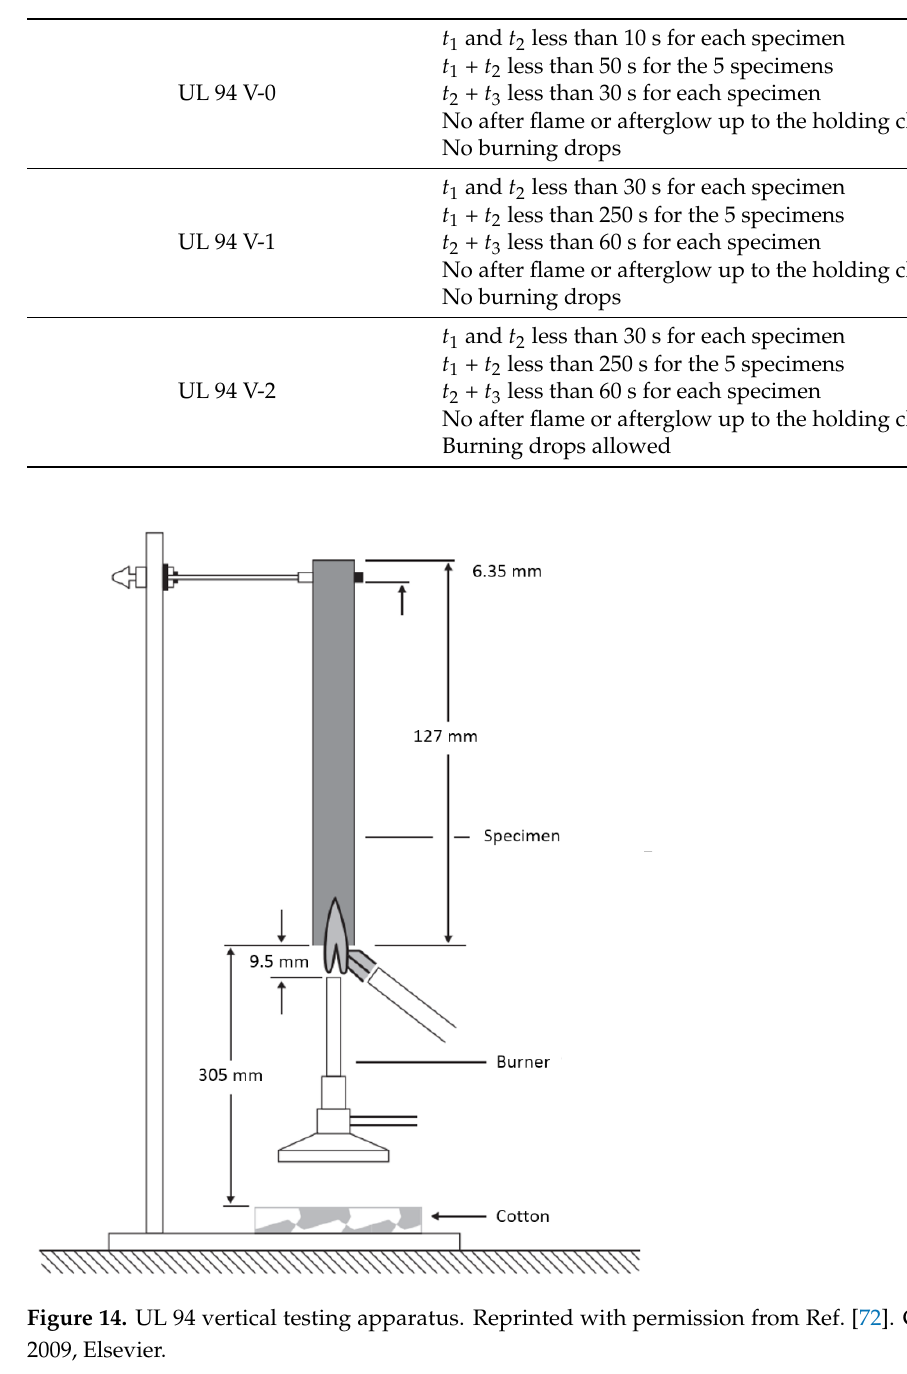
Table 5. UL 94 fire classifications. Reprinted with permission from Ref. [72]. Copyright 2009, Elsevier.